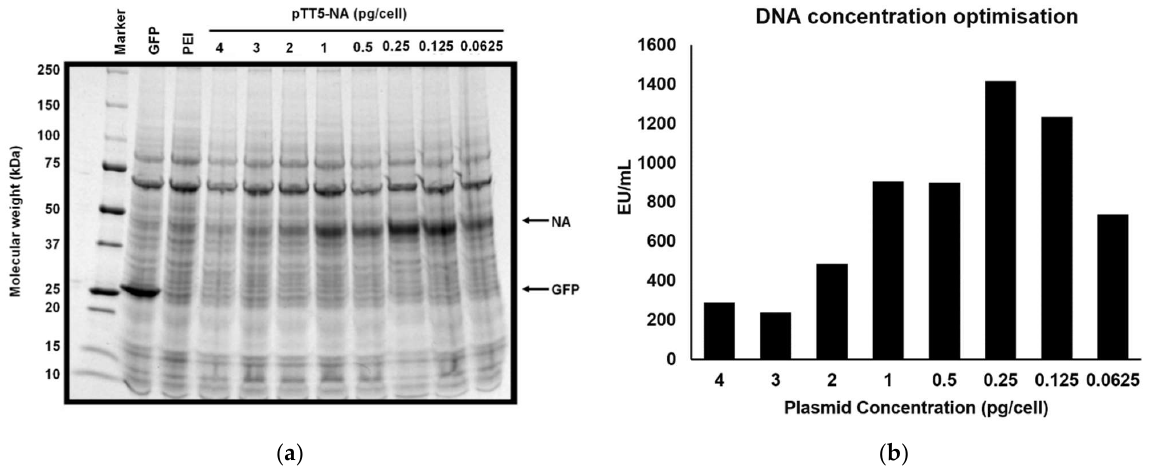
Figure 2. Optimisation of quantity of DNA in transfection for pTT5-NA (+SS −TET). 80 mL HEK293-6E cells (1 × 10 6 cells/mL) were transfected with 4, 3, 2, 1, 0.5, 0.25, 0.125 or 0.0625 pg/cell pTT5-NA (+SS −TET) plasmid. Previous trials had been performed at 1 pg/cell. ( a ) 6 days post transfection cell culture supernatants were analysed by SDS-PAGE for NA expression. The supernatant samples were concentrated 10× before SDS-PAGE analysis. GFP represents a positive control for recombinant protein expression (27 kDa). PEI represents a negative control for recombinant protein expression. Samples were loaded onto SDS-PAGE gel (4–20%) and visualized using Coomassie blue. ( b ) Reducing the amount of plasmid DNA to 0.25 pg/cell increases NA production. Following transfection with varying amounts of pTT5-NA (+SS −TET), the cell supernatant was analysed after six days of expression to assess NA activity. DNA quantity per cell is shown on the x-axis. NA activity is plotted in EU/mL where 1 EU (enzyme unit) represents the amount of NA required to convert 1 µmol MUNANA to 4-MU per minute.